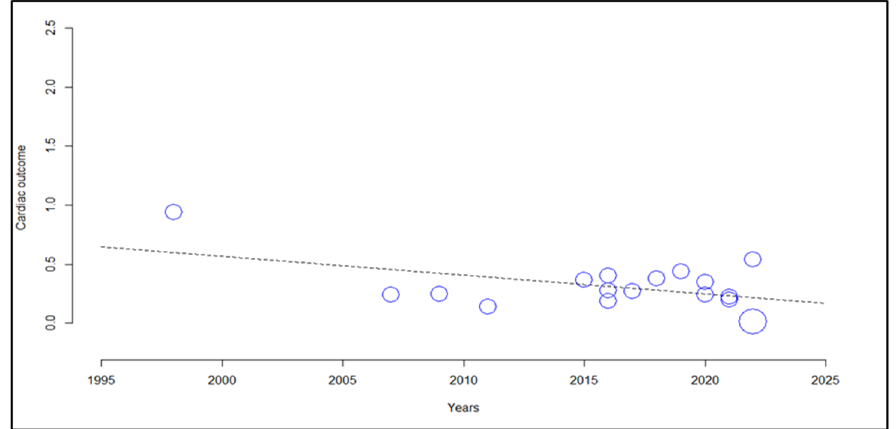
Figure 6. Scatter plot showing the frequency of cardiac events in patients with dengue through meta-regression.